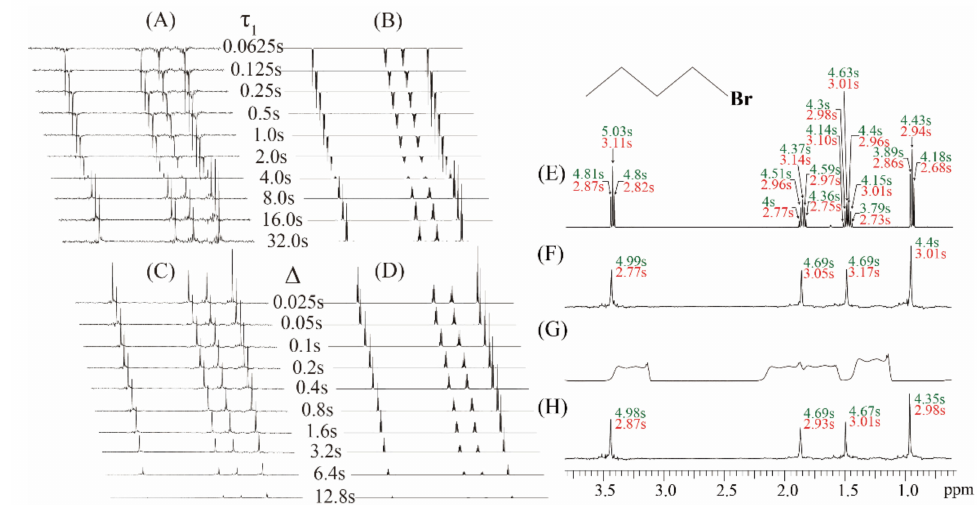
Figure 2. Experiments on the chemical sample of 1 M 1-bromobutane in (C 4 H 9 Br) in Chloroform- d (CDCl 3 ). ( A ) A group of 1D pure shift spectra by the real-time ZS-IR and ( B ) a group of 1D spectra by the IR, showing the T 1 relaxation evolution as the incremental inversion recovery delay, τ 1 , from 0.0625 to 32.0 s. ( C ) A group of 1D pure shift spectra by the real-time ZS-CPMG and ( D ) a group of 1D spectra by the CPMG, showing the T 2 relaxation evolution as the incremental spin-echo delay, ∆ , from 0.025 to 12.8 s. ( E ) Calculated T 1 and T 2 values from the conventional IR / CPMG and ( F ) the real-time ZS-IR / CPMG in a well-shimmed magnetic field. ( G ) The 1D spectrum acquired in a deshimmed magnetic field with a 177.35 Hz line width. ( H ) Calculated T 1 and T 2 values from the real-time ZS-IR / CPMG in the deshimmed magnetic field. Molecular structure of 1-bromobutane is shown in the top right of the figure, and all measured T 1 and T 2 are displayed in green and red fonts,